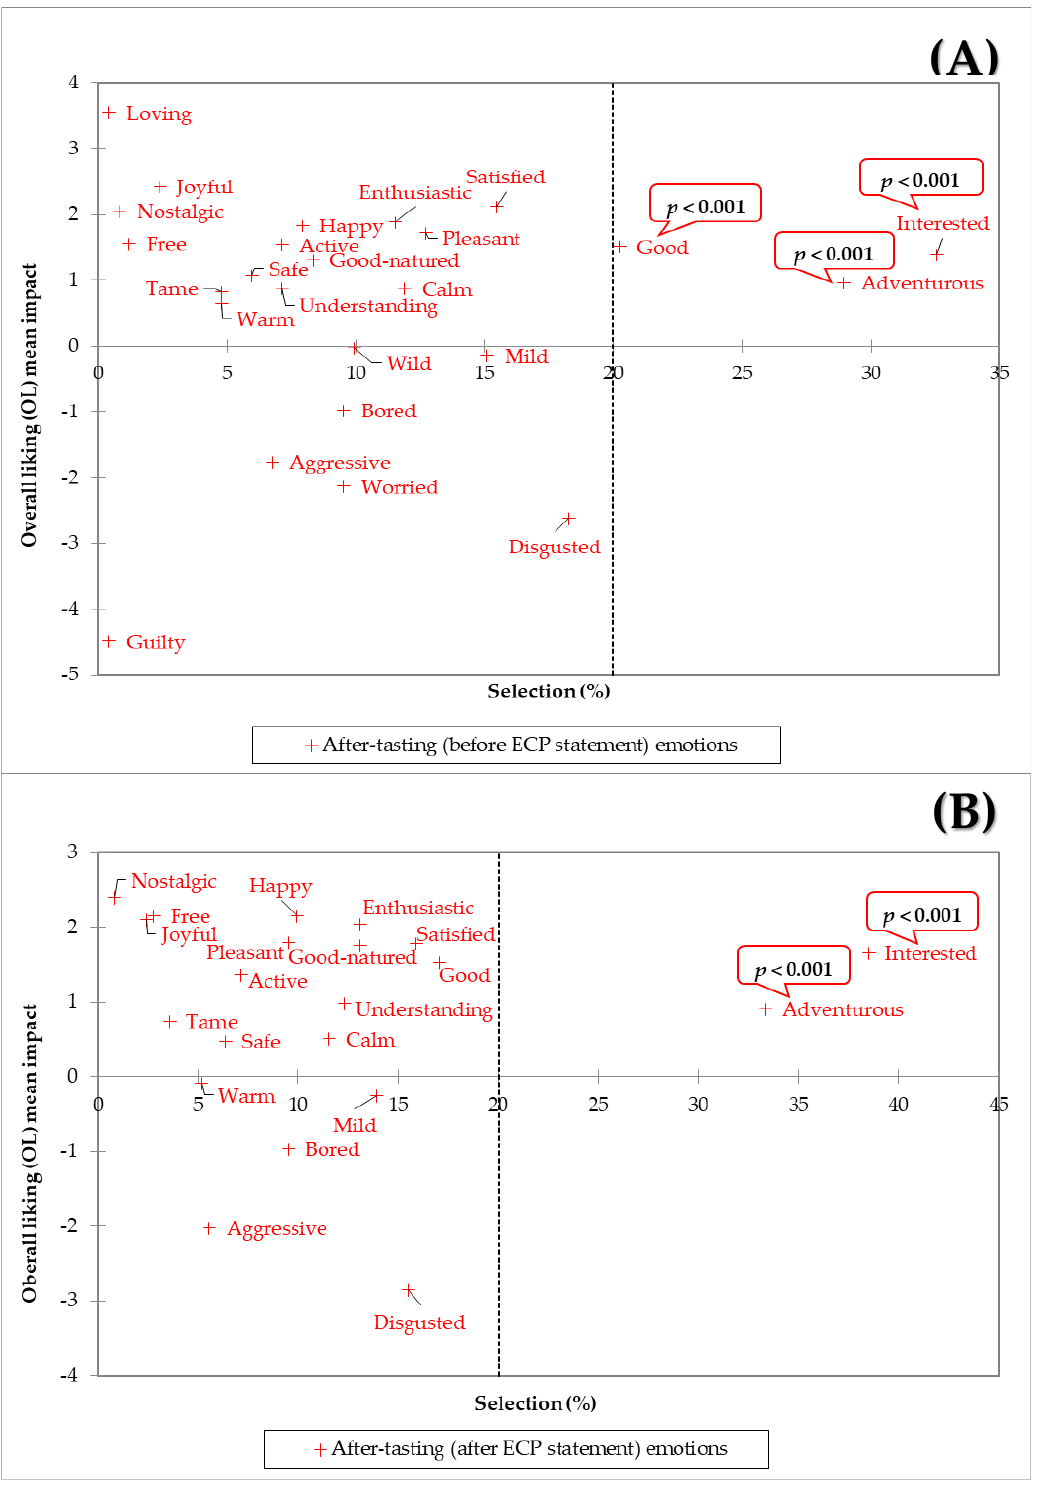
Figure 8. Treatments’ after-tasting overall liking (OL) mean impact (mean OL difference from present vs. absent categories for each emotion with a 20% population threshold size) vs. significant ( p < 0.05, 2-sample t -test) emotions in the after-tasting moment (%) from n = 84 consumers ( A ) before edible cricket protein (ECP) statement and ( B ) after ECP statement. After-tasting emotions and OL from treatments (Figure 1) were pooled together for the analysis.